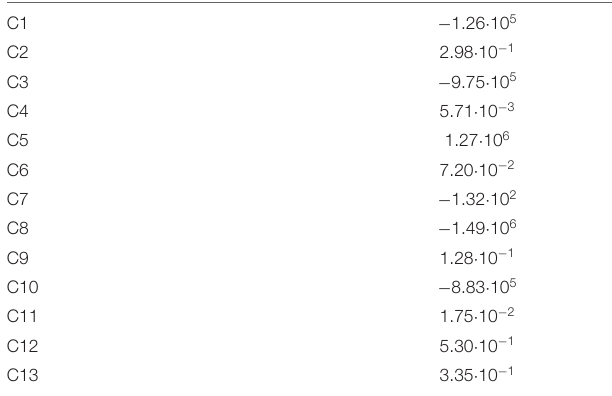
TABLE 1 | Values of optimized coefficients for obtaining correlations for specific enthalpy of ethylene glycol-water